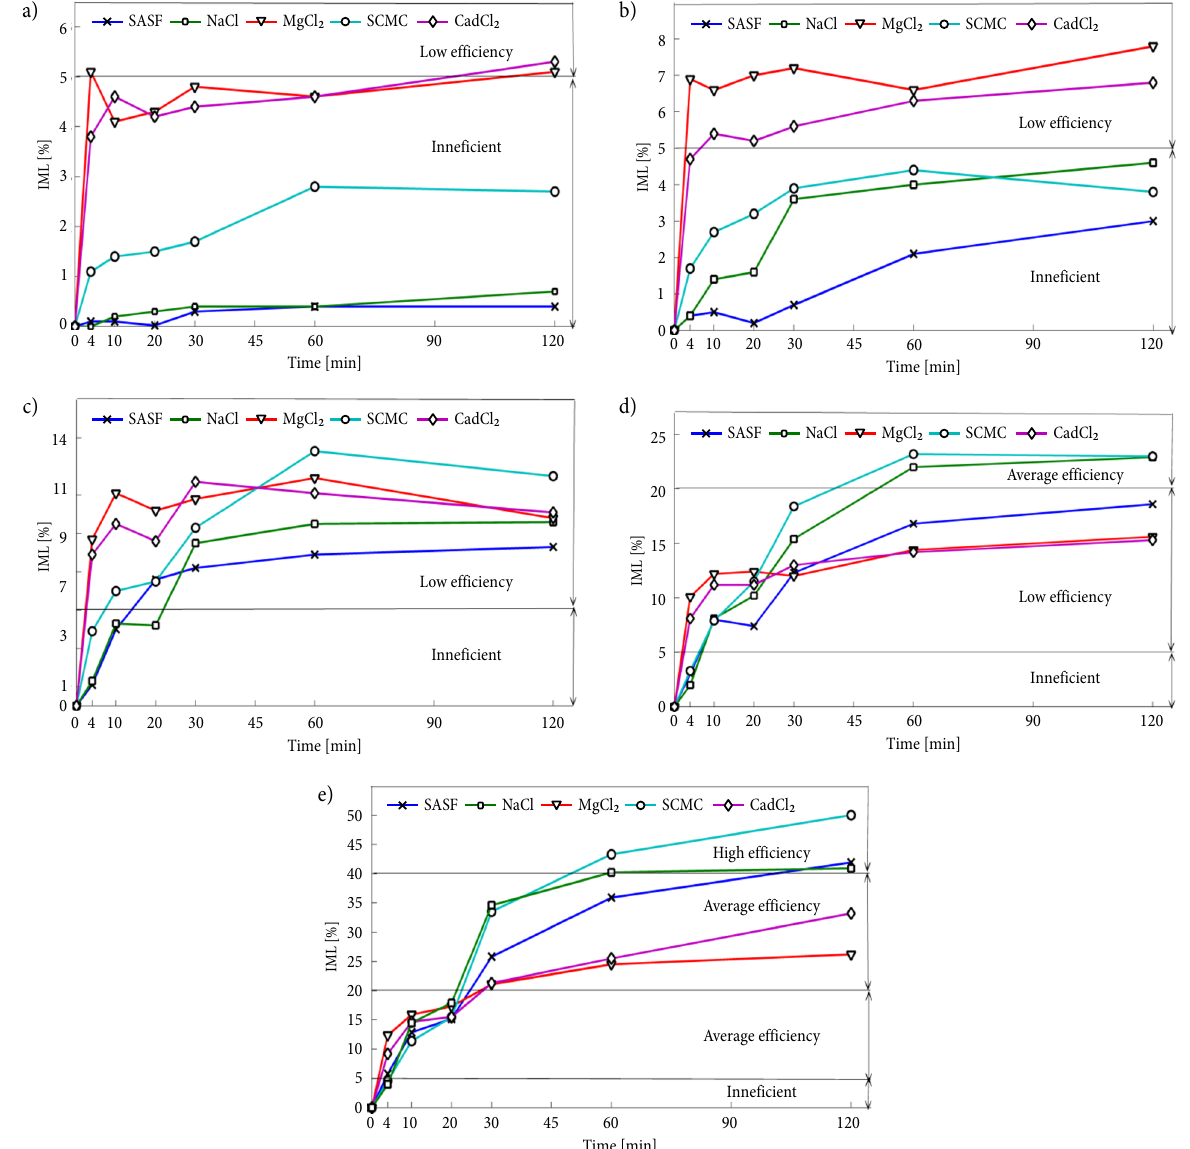
Fig. 6. Dependence of the efficiency of DMs on the ice melting time at different temperatures: a – –20 ° C; b – –15 ° C; c – –9 ° C; d – –6 ° C; e – –3 °